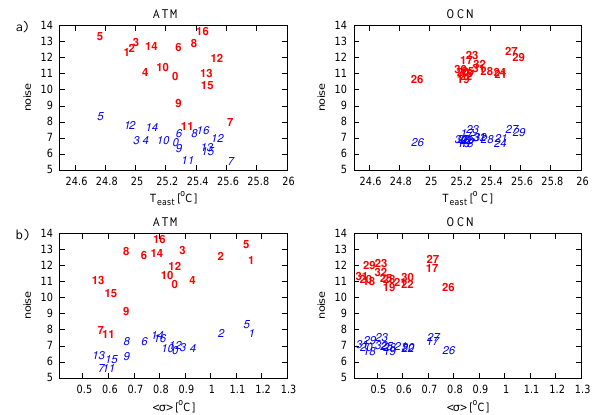
Fig. 7. (a) Atmospheric noise amplitude in [10 − 3 Nm − 2 ] vs. SST, T east and (b) vsSSTstandarddeviation(ENSOamplitude), h σ i for all members. Red are the western mean values, blue the eastern ones.